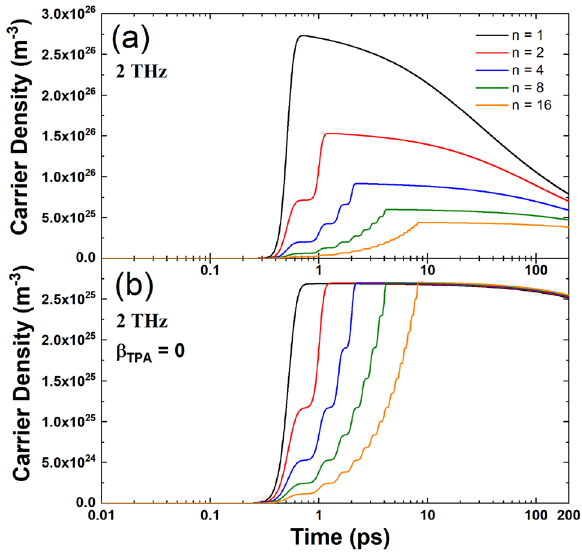
Figure 3. Carrier density at the surface of laser-irradiated silicon obtained in the framework of the nTTM with ( a ) β TPA = 0 and ( b ) β TPA = 0